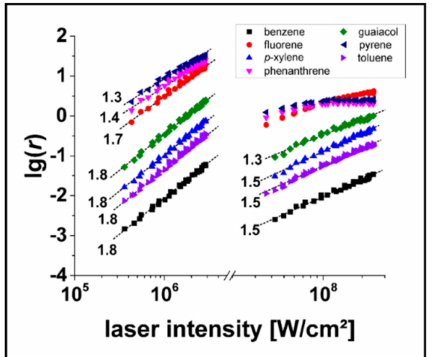
Figure 4. Intensity-dependent REMPI response of selected aromatic and polycyclic aromatic compounds; values on the left side correspond to a lens position of 3.5 cm relative to the focal point, whereas data points on the right side were determined at the focus position. The slope of the regression line is given for each compound; similar values for the analytes compared to toluene (reference) result in constant relPICS over a wide intensity